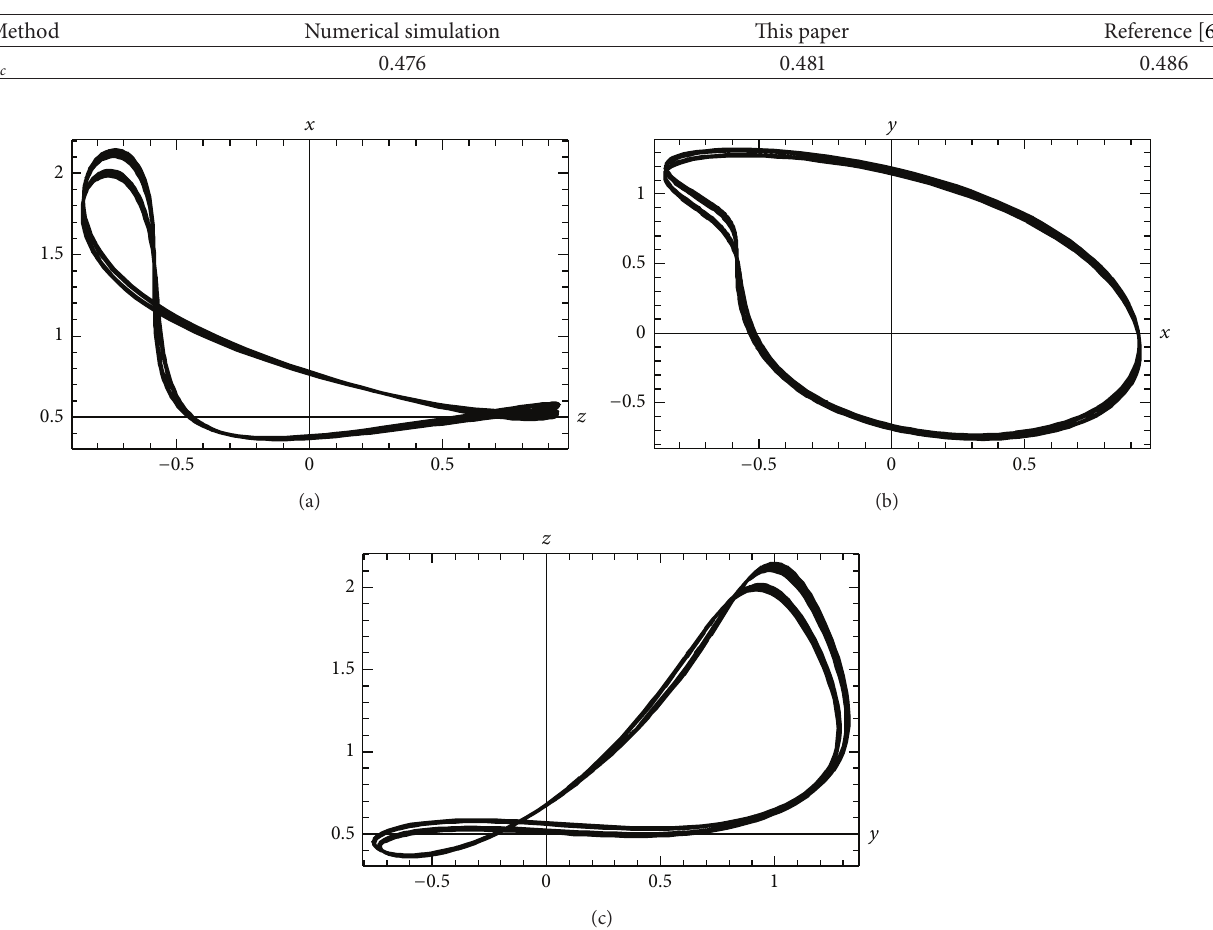
Table 2: Critical value for the second period-doubling bifurcation.